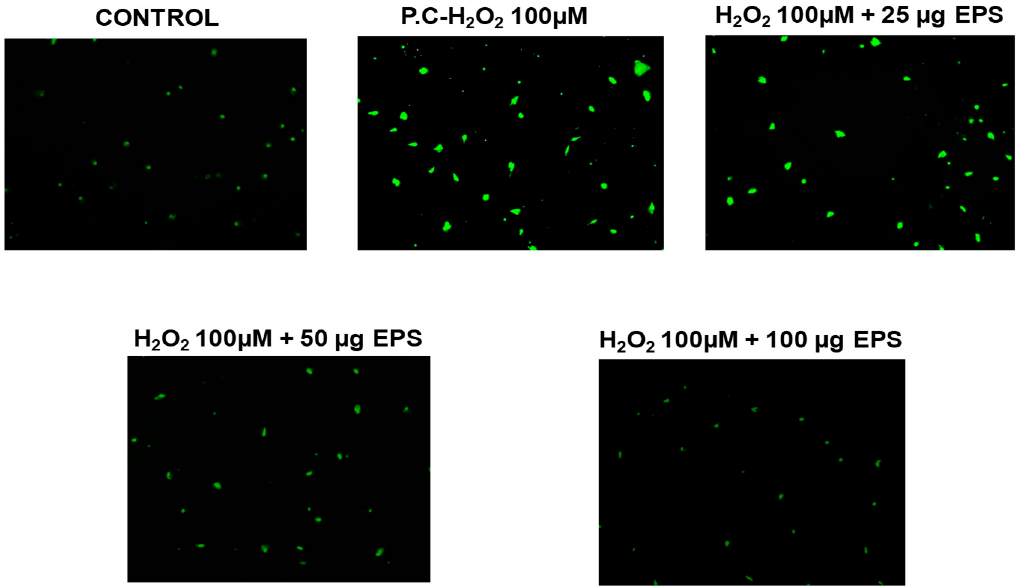
Figure 11. ROS inhibition assay using EPS obtained from Halococcus sp AMS12.